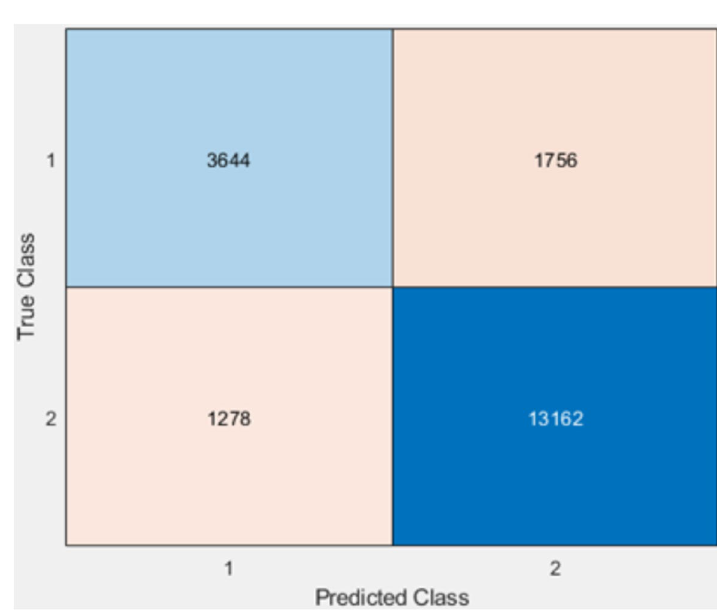
Fig. 12 The ENSEMBLE classifier’s confusion matrix for voice replay